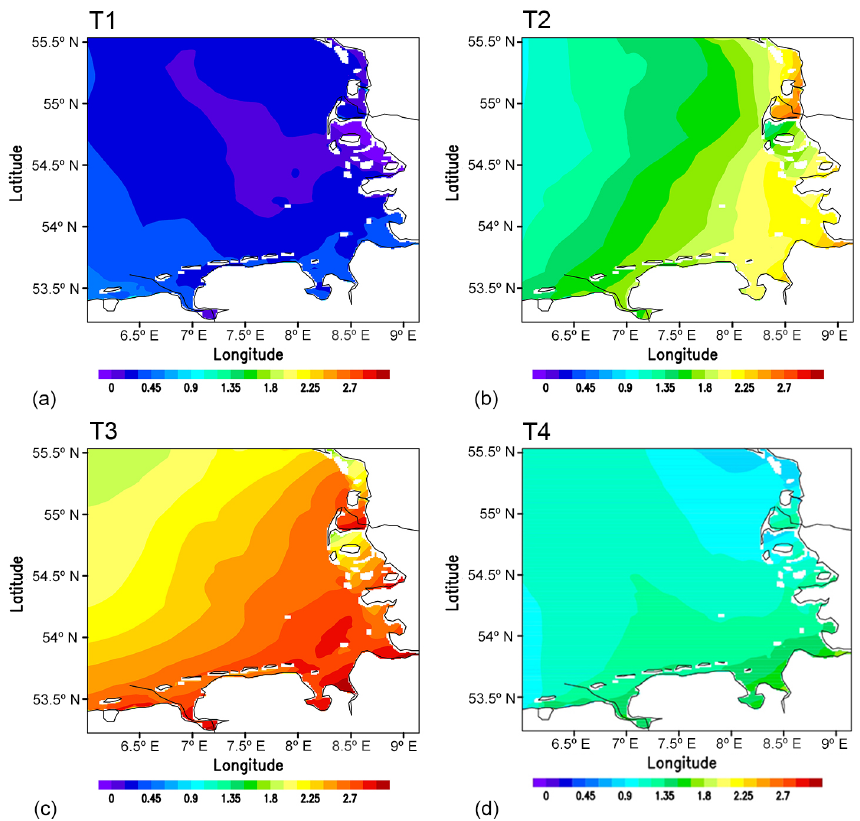
Figure 11. Maximum surge in (m) over the four different tidal periods (T1–T4) as shown in Fig. 9.